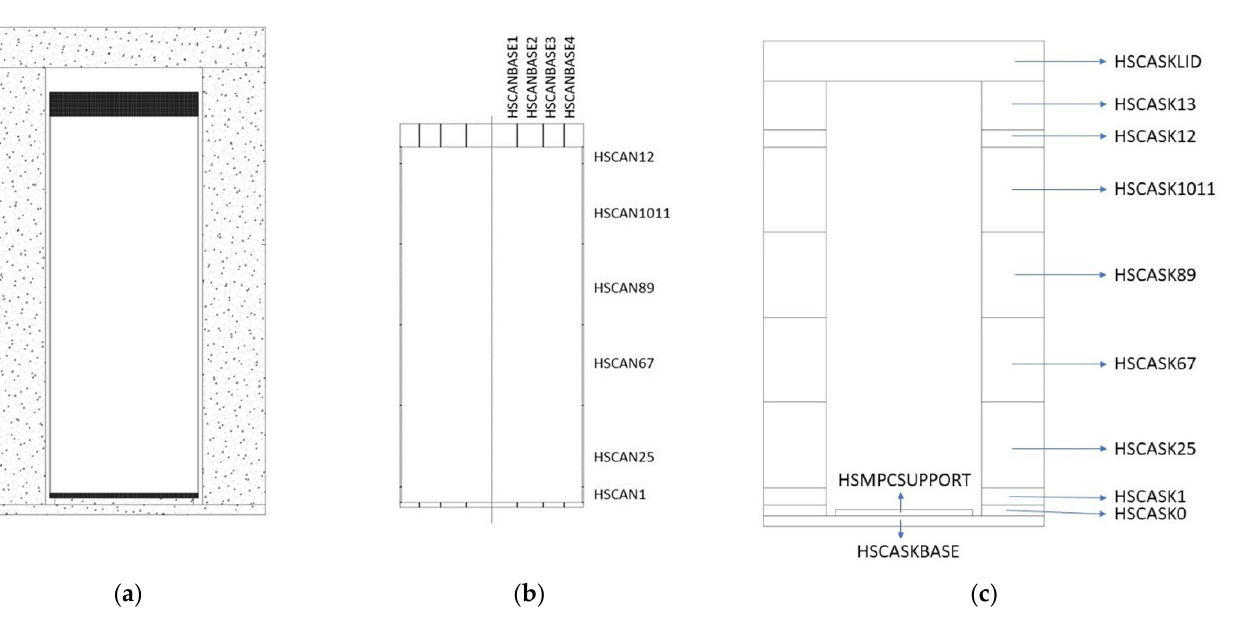
Figure 2. The ( a ) MPC and overpack walls; ( b ) the MPC heat structures; ( c ) the overpack heat structures.